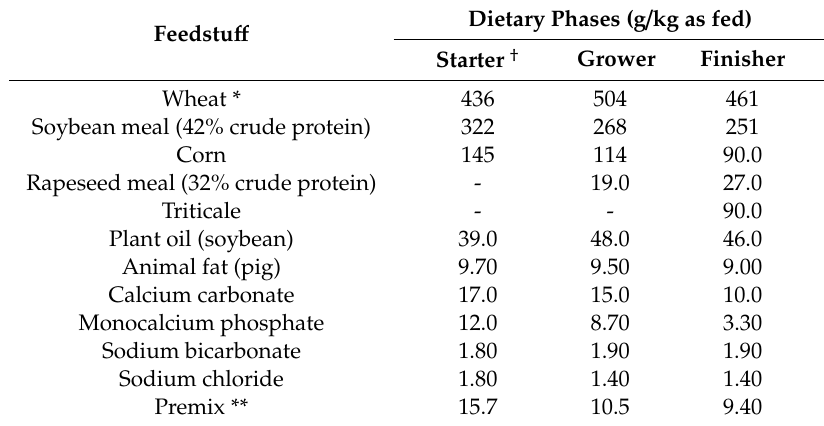
Table 1. Composition of broiler commercial diets during three the growing phases (g / kg as fed). Dietary Phases (g / kg as fed) Feedstu ff Starter † Grower Finisher Wheat * Soybean meal (42% crude protein) 322 268 Corn